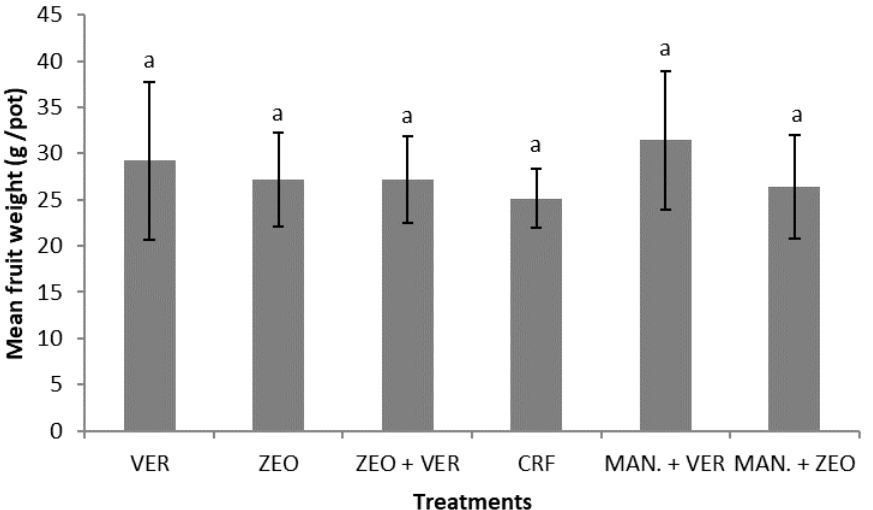
Figure 2. Mean fruit weight (g/pot) of the pepper plants among the treatments. The different letters on the bars signify statistically significant differences among the treatments, according to Duncan’s multiple range test, for p ≤ 0.05. VER: vermiculite; ZEO: zeolite; CRF: controlled-release fertilizer; MAN: manure. Table 2. Elongation rate (cm/day) of the main shoot of pepper plants during the 5 months of the experiment.